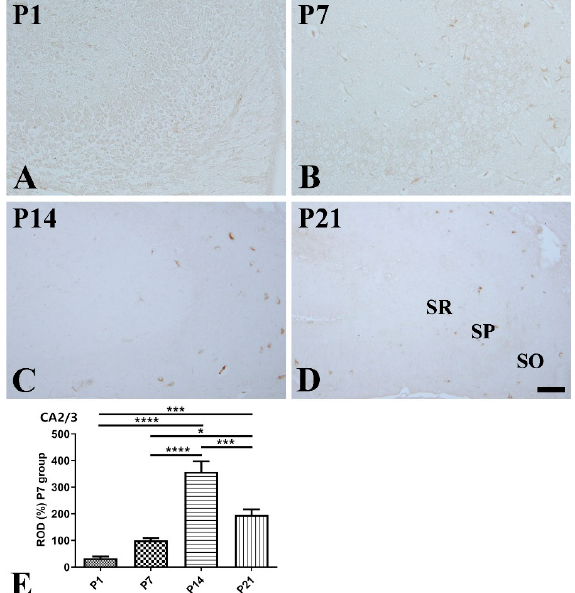
Figure 3. Immunohistochemical staining for somatostatin (SST) in the mouse hippocampal CA2/3 region at P1 ( A ), P7 ( B ), P14 ( C ), and P21 ( D ). SO stratum oriens; SP stratum pyramidale; SR stratum radiatum. Scale bar = 50 µm. ( E ): The number of SST-immunoreactive cells in the hippocampal CA2/3 region at P1, P7, P14, and P21 are expressed as a percentage of the values in the P7 group ( n = 5 per group; * p < 0.05, *** p < 0.001, and **** p < 0.0001). All data are represented as the mean ± standard error of the mean.